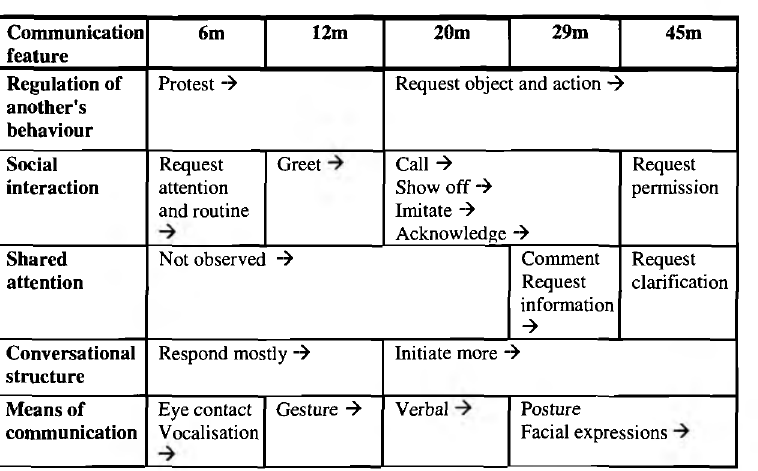
Table 6: Participant's communication development based on Weth erby and Prizant (1989).